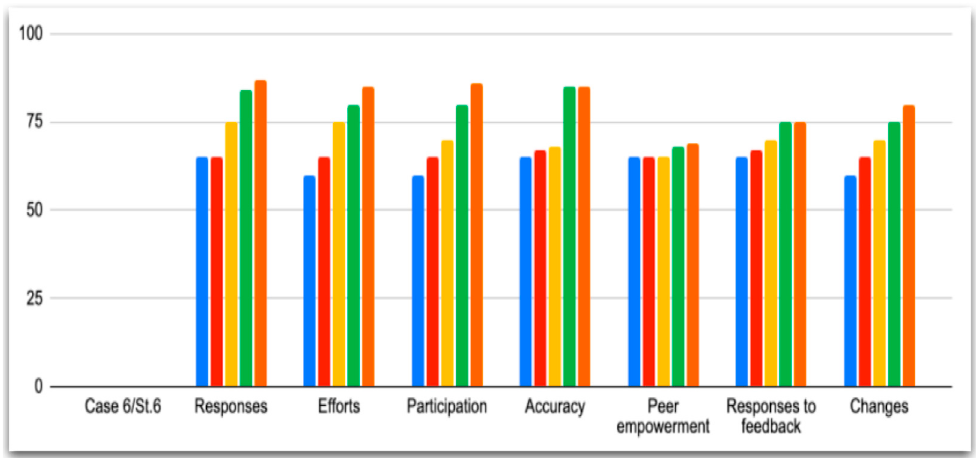
Figure 6. Vocabulary and spelling progress during alternative assessment online/Case 6.